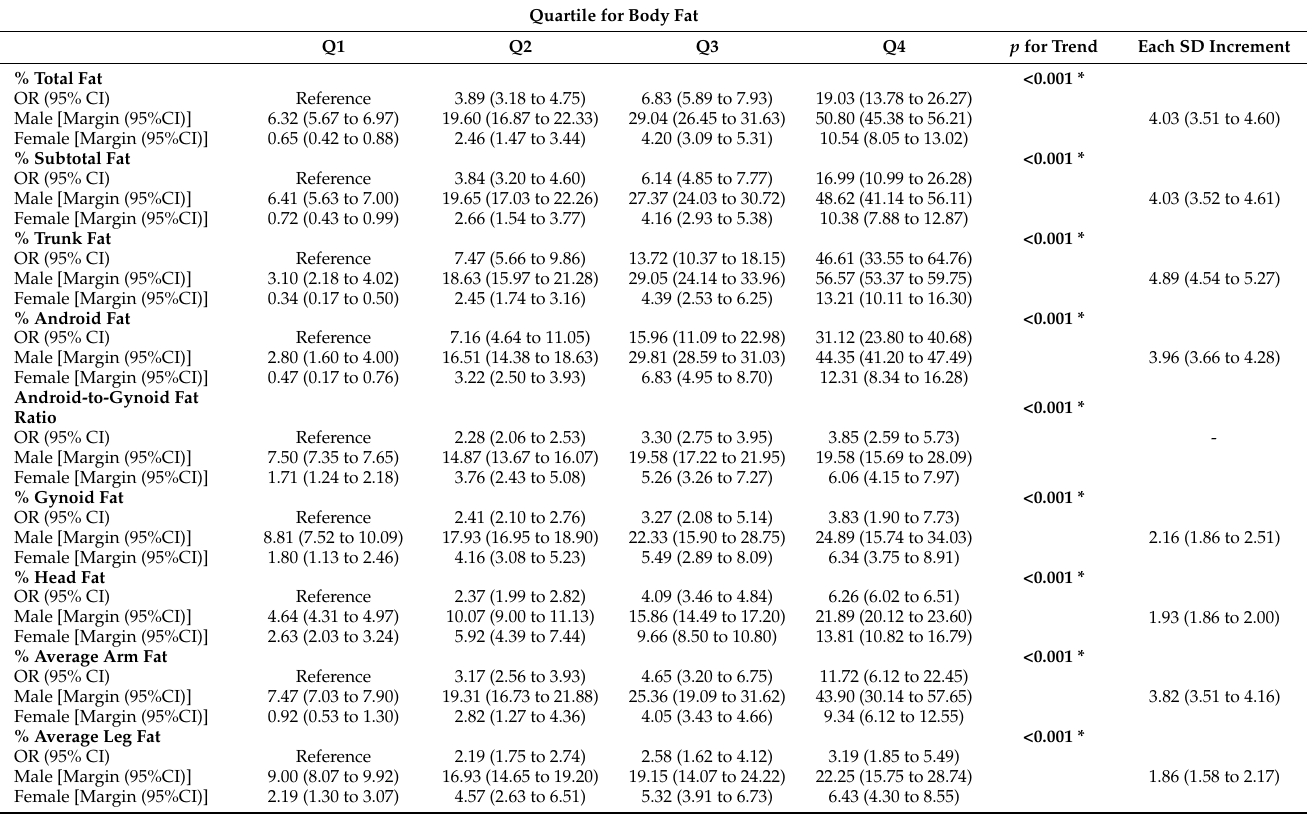
Table 3. Multivariate Analysis of Body Fat on Risk of NAFLD Development in Non-obese Population. Quartile for Body Fat